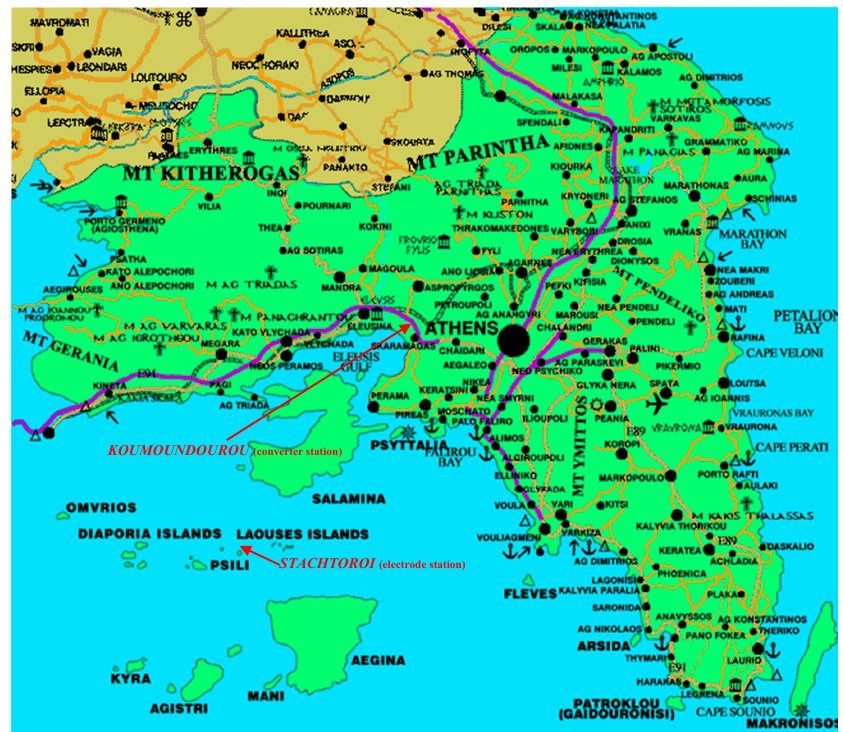
Figure 4. Geographical map of Attica mentioning the electrode station and converter station [59].